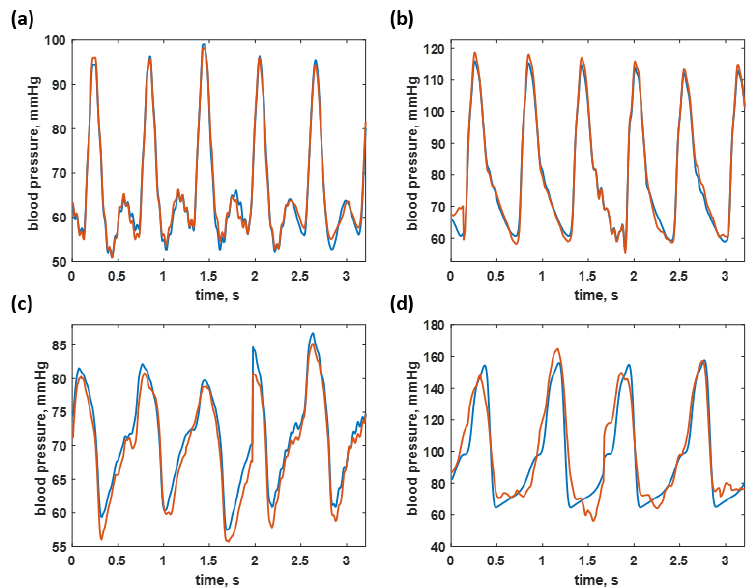
Figure 12. Shows the blood pressure predicted by the trained neural network (red curves) compared to the untrained actual blood pressure signal (blue curves) across four ranges: ( a ) 95/51 mmHg (healthy); ( b ) 110/62 mmHg (healthy); ( c ) 78/53 mmHg (hypotension); and ( d ) 179/70 mmHg (hypertension).